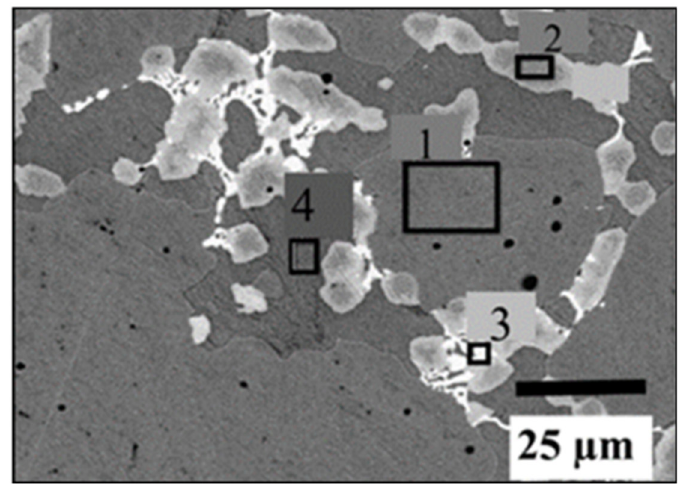
Figure 3. EDX analysis of TiFe with the simultaneous addition of 2 wt.% Zr + 2 wt.% V. Table 3. Chemical composition of each phase present in TiFe with the simultaneous addition of 2 wt.% Zr + 2 wt.% V (uncertainty on all values is ± 1). Alloy Ti (at.%) Fe (at.%) V (at.%) Zr (at.%) TiFe + 2 wt.% Zr + 2 wt.% V